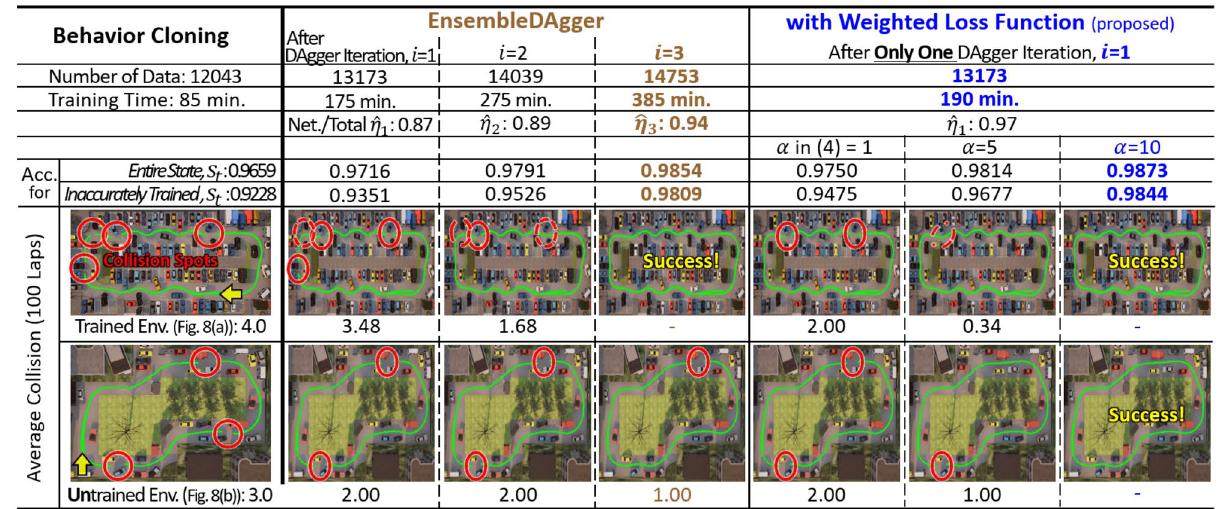
Figure 16. Driving test results; the green line is the vehicle trajectory; the red circle indicates the collision spot; The closer the circle is to the solid line, the higher the collision frequency is. To obtain the policy that the vehicle